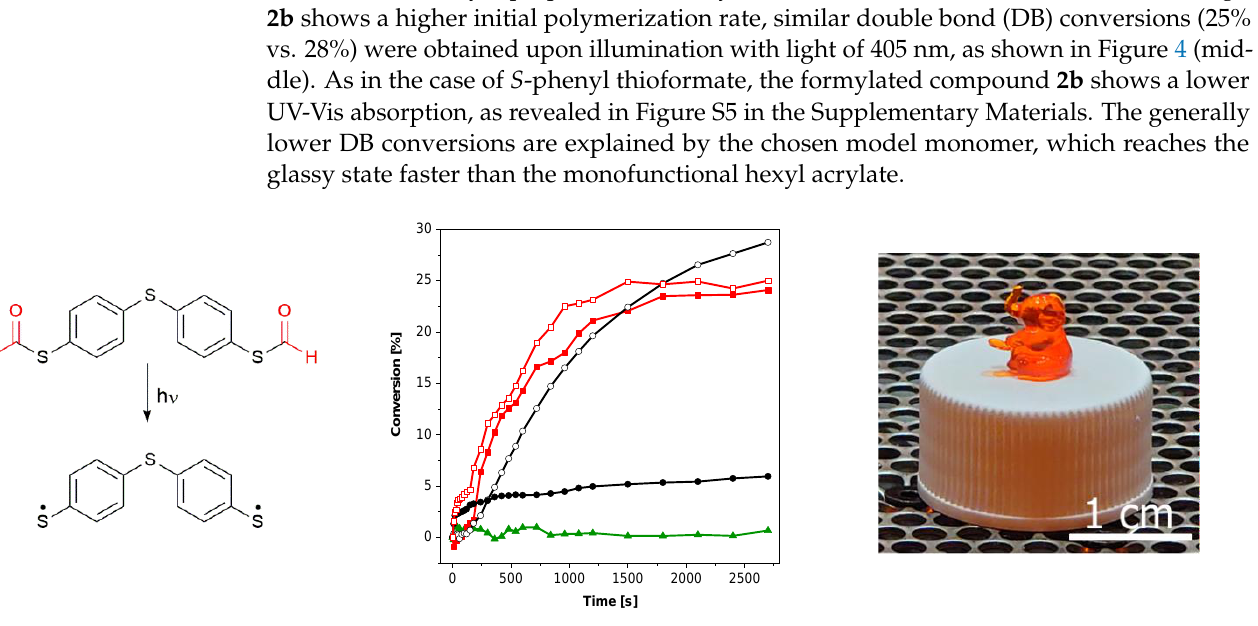
Figure 4. ( Left ): photodecarbonylation reaction of 2b . ( Middle ): conversion of the acrylate groups of TMPTMA under UV illumination (red line with open square: 1 mM 2b , 0 days of storage at 50 ◦ C; red line with filled square: 1 mM 2b , 7 days of storage at 50 ◦ C; black line with open cycle: 1 mM 2a , 0 days of storage at 50 ◦ C; black line with filled cycle: 1 mM 2a , 7 days of storage at 50 ◦ C; green line with filled triangles: without PI; 405 nm, 19.15 mW cm − 2 ). ( Right ): photograph of the printed test structure.